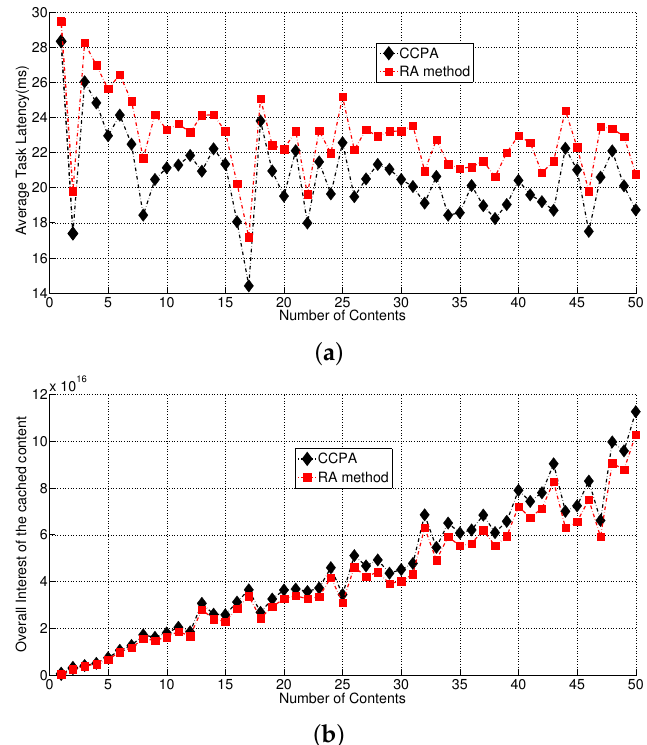
Figure 4. Comparisons of the average UE latencies and overall content interests led by CCPA and the RA method. ( a ): Average Task Latency; ( b ): Overall Content